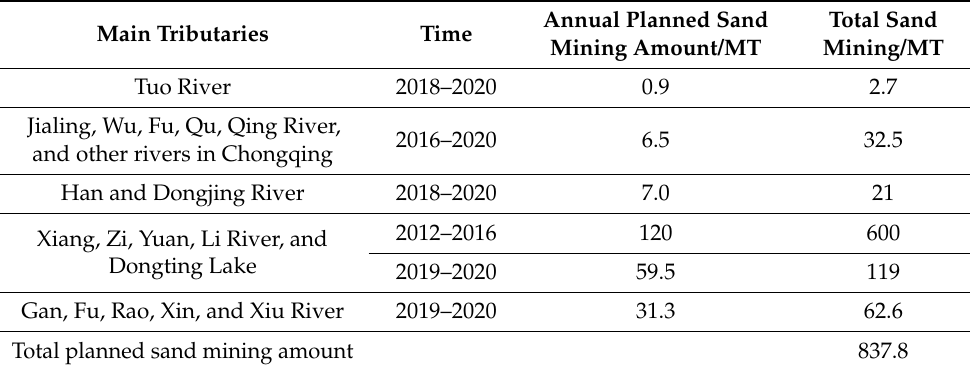
Figure 2. Sand mining planning data for the mainstream YR during 2004 – 2020. Table 5. Planned data of sand mining in the tributaries of the